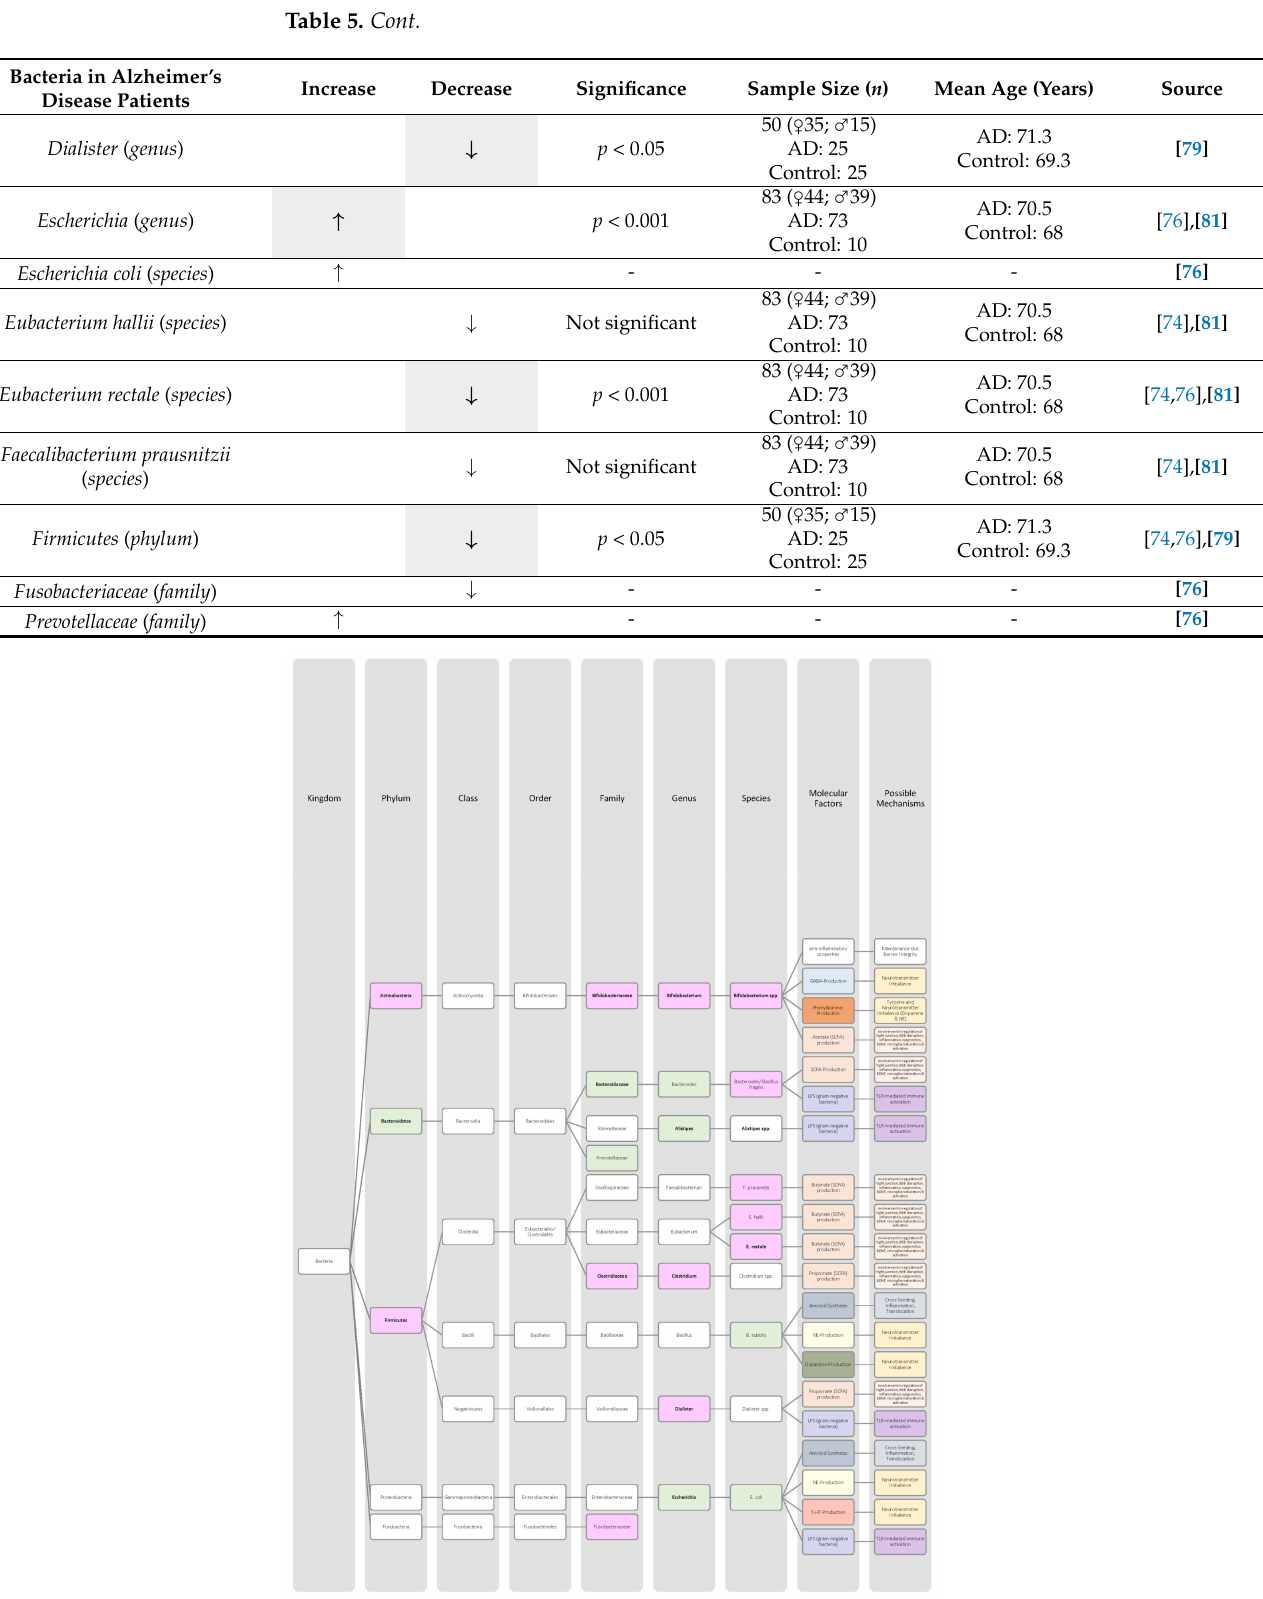
Figure 7. Visual representation of the changes in microbiota composition in Alzheimer’s disease (AD) patients from Table 5. The pedigree design highlights the taxonomic classification of the dysbiotic bacteria. Light green cells stand for an increase and the light red cells for a decrease,